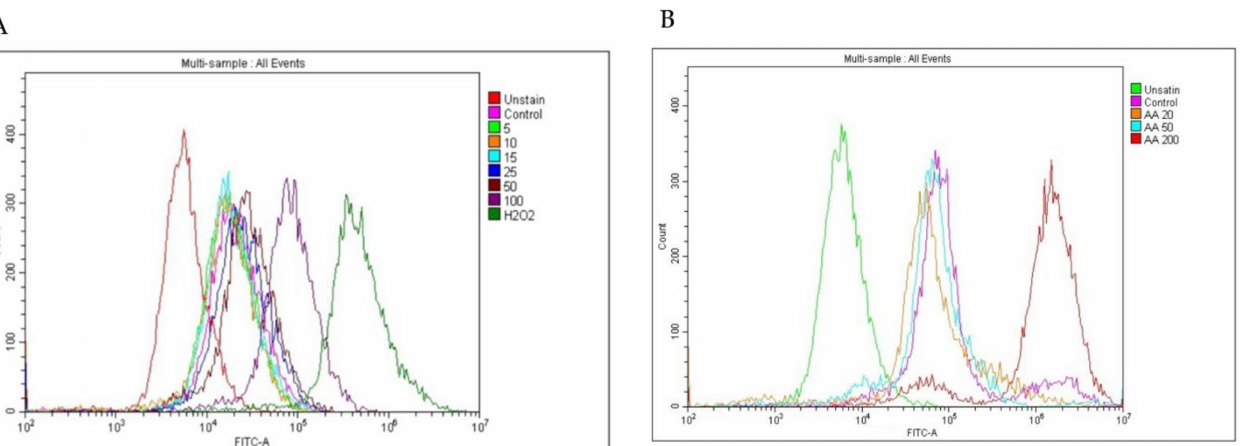
Figure 4. HCT 116 cells were seeded in 6-well plates and allowed to grow until 80–90% confluence, then scratched with a sterile 200 µ L tip to create a wound and further treated with PPE (2 µ g/mL and 3 µ g/mL) or 5FU (0.2 mM). ( A ) Images of the scratched wound of the control, PPE-, and 5FU-treated recorded at 0 h, 24 h, and 48 h; ( B ) Relative closure length of the scratched wound as compared with control.The values indicate ± SD ( n = 3); ** p < 0.01 vs. control and *** p < 0.001 vs. control.